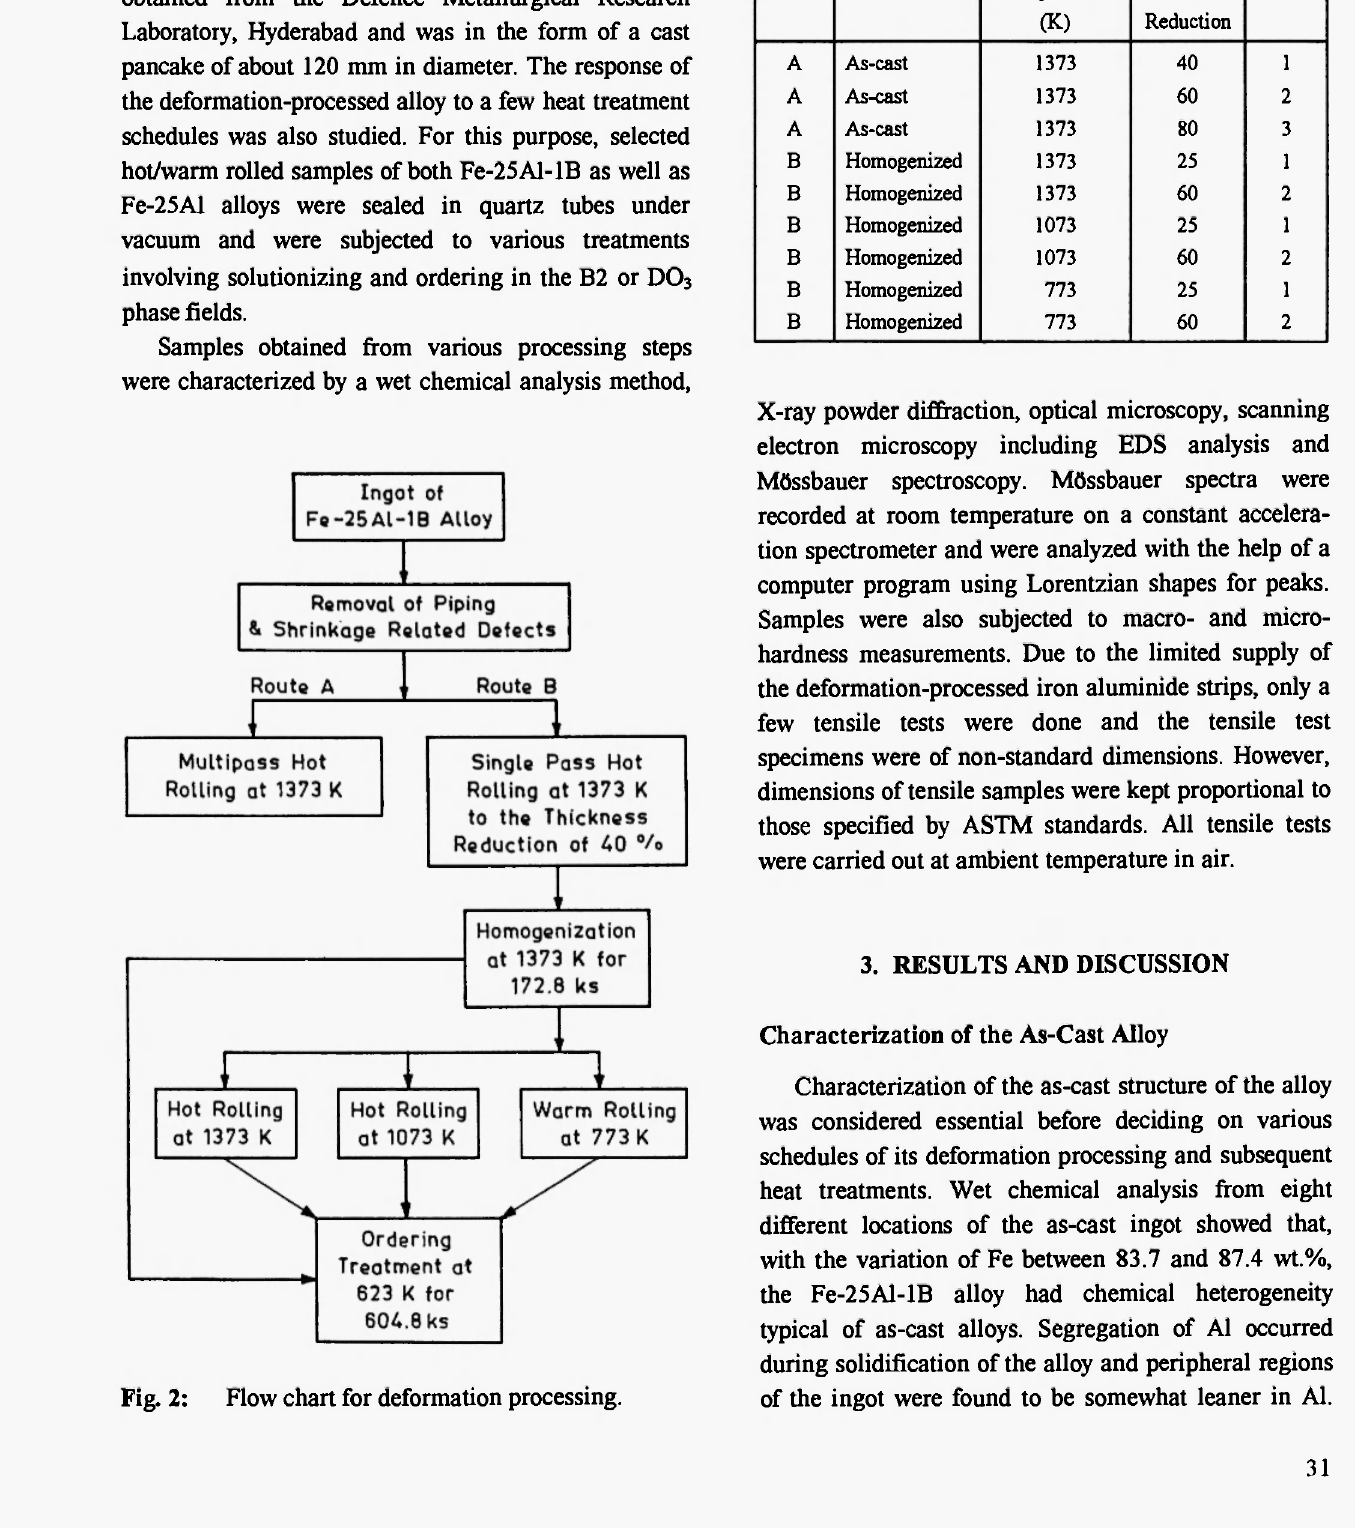
Fig. 2: Flow chart for deformation